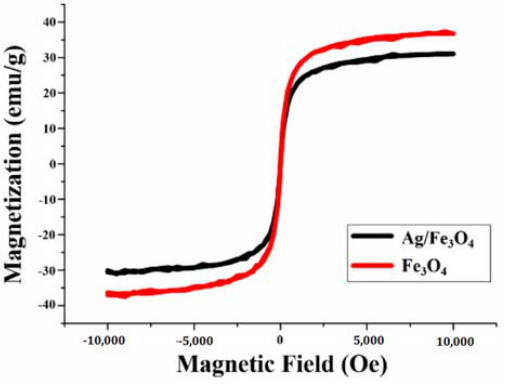
Figure 3. Magnetic saturation of bare Fe 3 O 4 and Ag/Fe 3 O 4 nanoparticles.